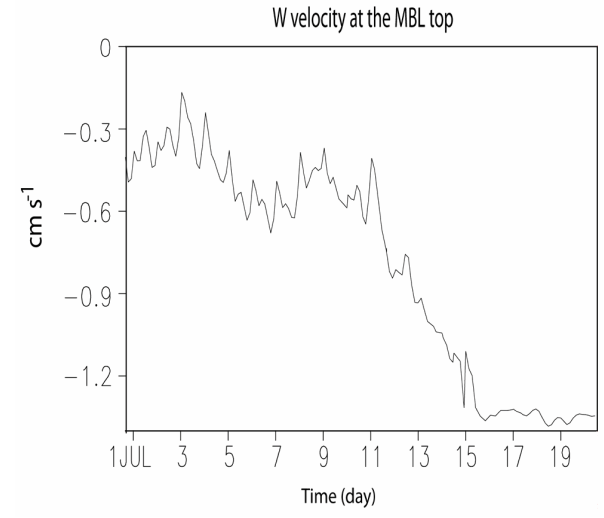
Fig. 14. Time series of area-averaged precipitation rate (mmday − 1 ) at cloud base (or at the LCL when clouds are absent) (solid line) and at the surface (dashed line) for the CSRM run.